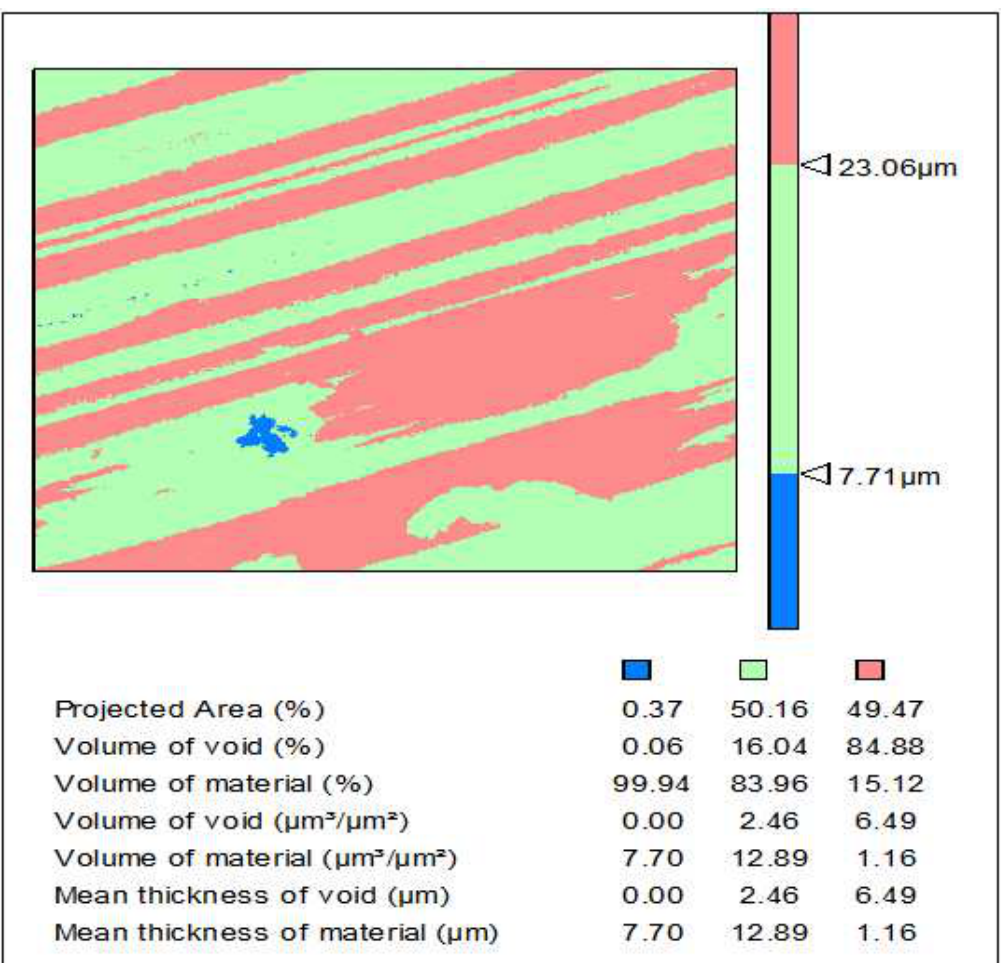
Figure 8. Surface topology (x50) and wearing worn distribution of alloyed Al-CuMgMn with laser 1.9 kW